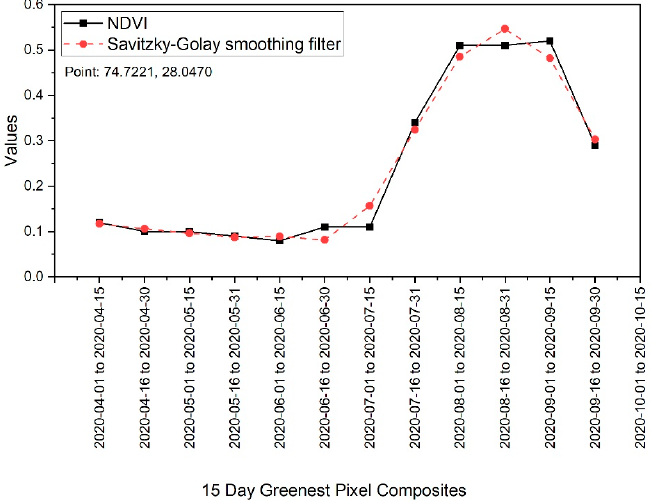
Figure 4. Kharif season time series NDVI signature.